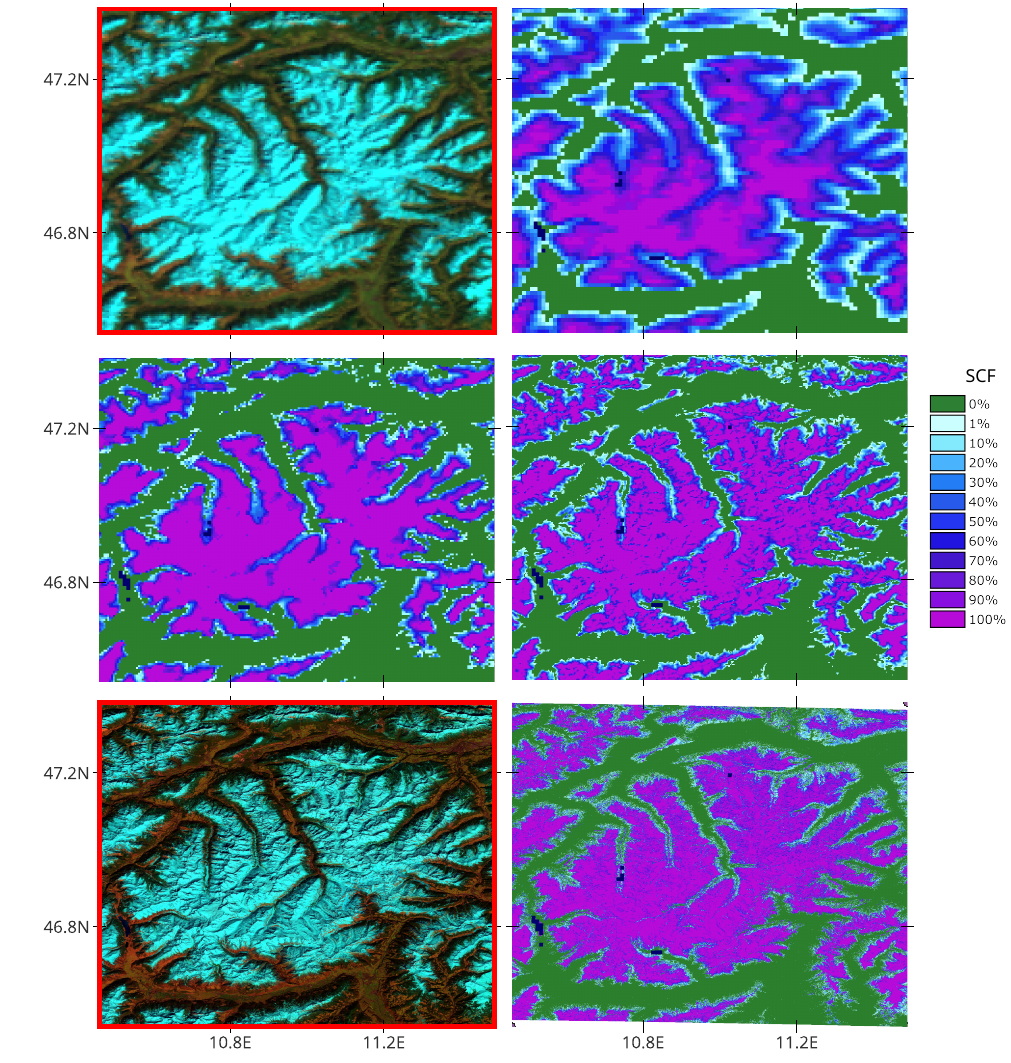
Figure A7. ( Top left ): Sentinel-3B SLSTR false colour composite (bands 5, 3 and 1) taken on 2 April 2020. ( Top right ): LAMSU SCF from Terra MODIS data at 1000 m ground resolution. ( Center left ): LAMSU SCF from Suomi-NPP VIIRS data at 500 m ground resolution. ( Center right ): LAMSU SCF from Sentinel-3B SLSTR and OLCI data at 250 m ground resolution. ( Bottom left ): Sentinel-2A MSI false colour composite (bands 11, 8A and 3) taken on 1 April 2020. ( Bottom right ): LAMSU SCF from Sentinel-2A MSI data at 20 m ground resolution. The top and middle row are from 2 April 2020. The bottom row is from 1 April